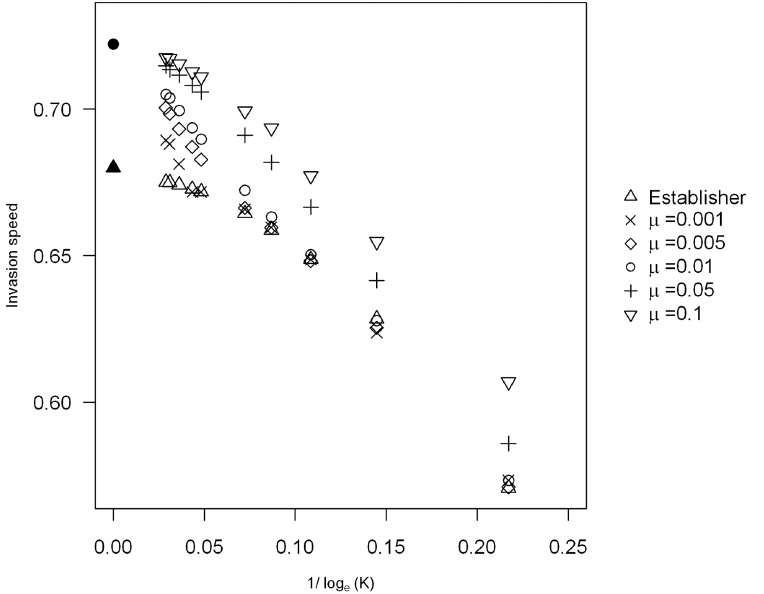
Figure 5. Anomalous invasion speeds when individual morph speeds are similar. The triangles represents the establisher morphs speed, the crosses the disperser morphs speed and the circles the invasion speed when both morphs are present. Parameter values used were r e ~ 0 : 56 , r d ~ 0 : 13 , D d ~ 0 : 8 , D e ~ 0 : 15 , m ~ 0 : 001 and K ranges from K ~ 100 to K ~ 10 13 .